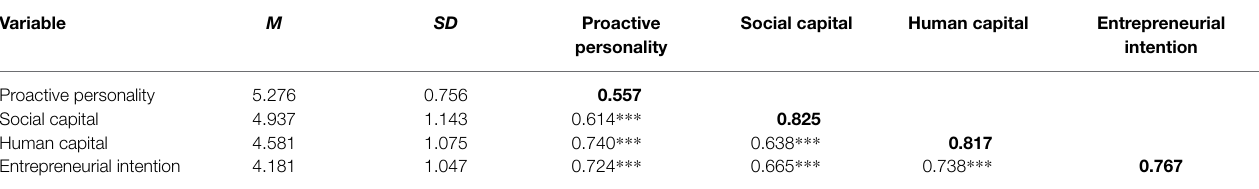
TABLE 3 | Summary of the descriptive statistics and correlation analysis. Variable